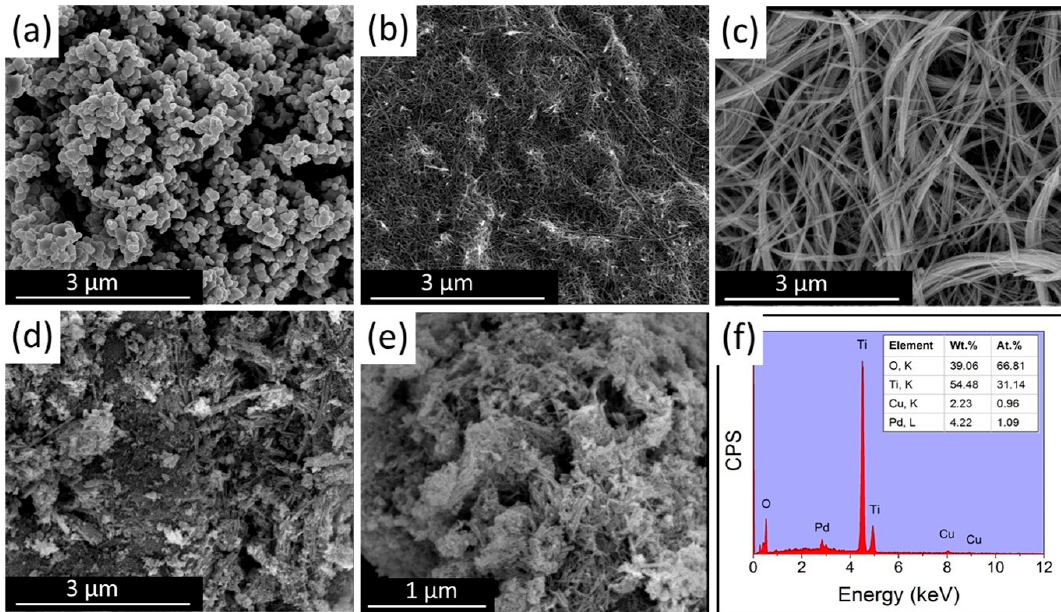
Figure 1. SEM images of ( a ) TiO 2 sphere; ( b ) TiO 2 nanotube; ( c ) TiO 2 nanowire; ( d , e ) Pd-Cu–TiO 2 nanowire catalyst; and ( f ) elemental analysis of Pd-Cu/TiO 2 nanowire catalyst.